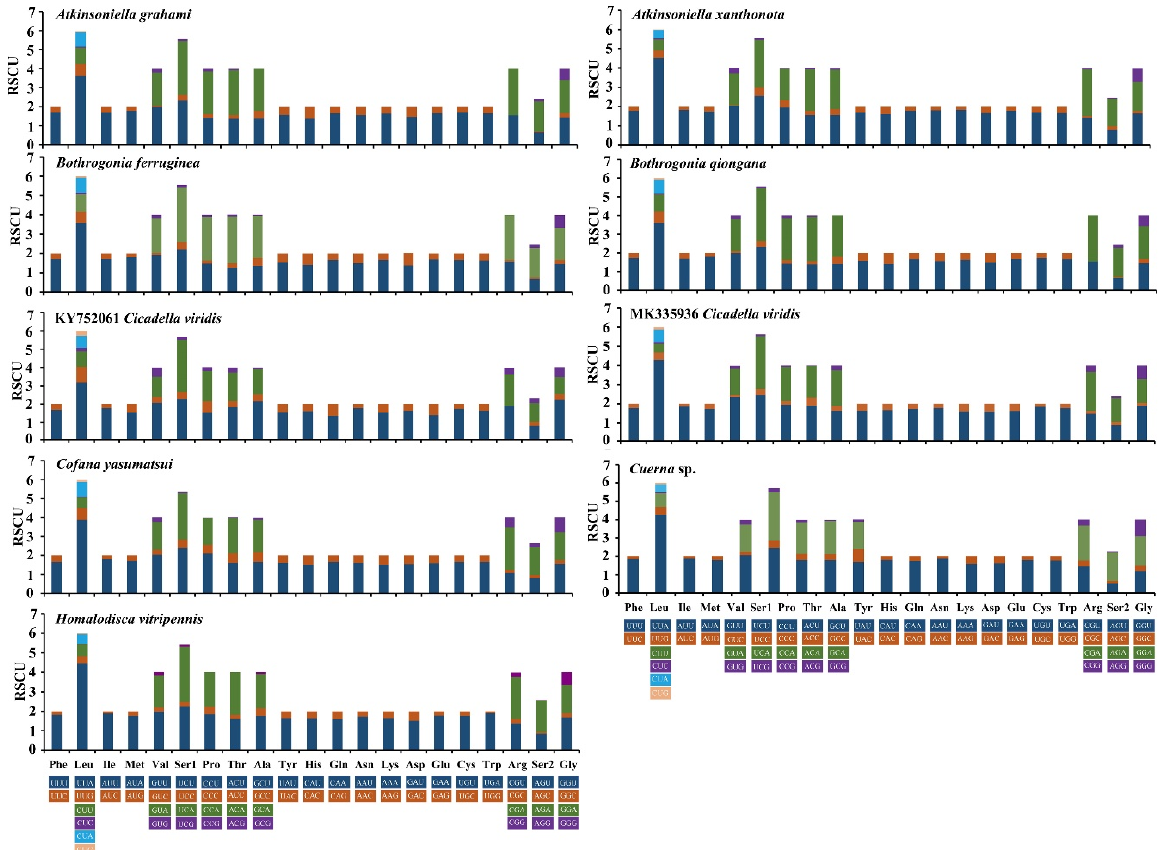
Figure 3. Relative synonymous codon usage (RSCU) in protein-coding genes (PCGs) of the mitogenomes of Atkinsoniella grahami , Atkinsoniella xanthonota, and other six Cicadellinae species. Codon families are indicated in boxes below the x -axis; the colors correspond to the stacked columns, and frequency of RSCU is provided on the y -axis.